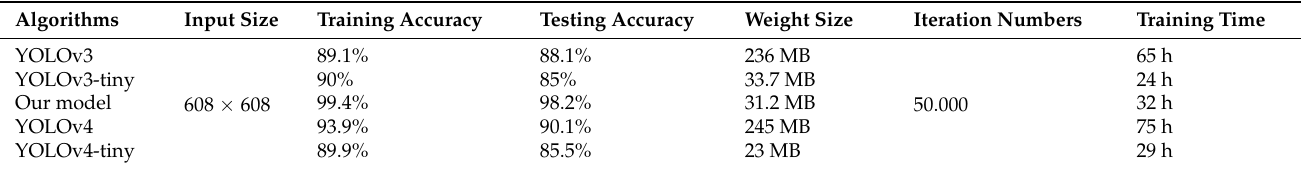
Table 2. Performance comparison results of the YOLO models.